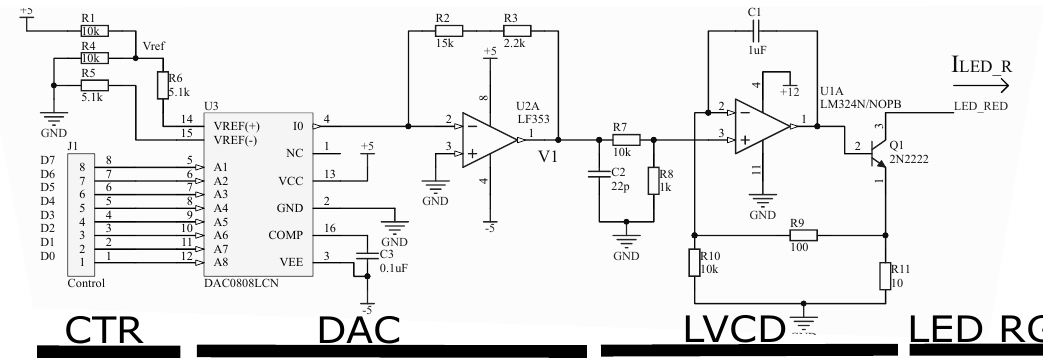
Figure 3. Electrical circuit of the